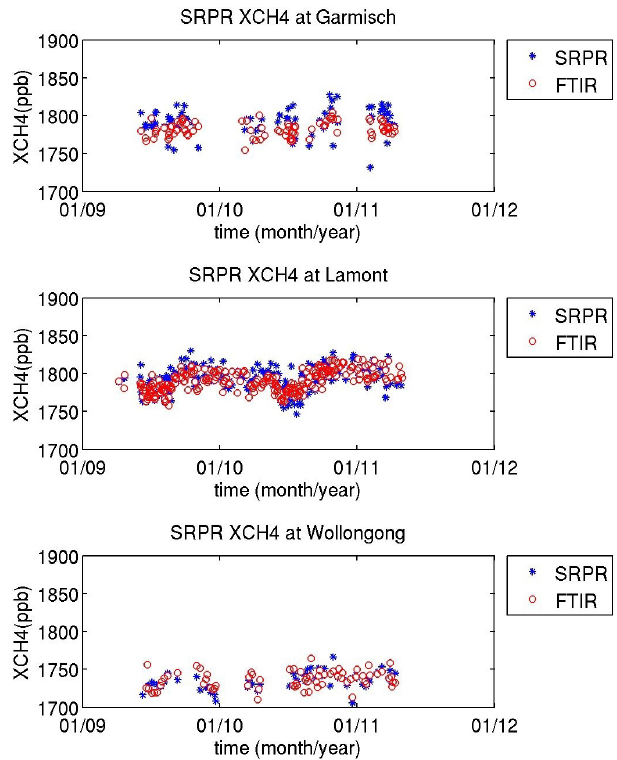
Figure 15. Daily averaged time series of paired SRPR and TC- CON FTIR XCH 4 at Garmisch (top), Lamont (mid) and Wollon- gong (bottom).